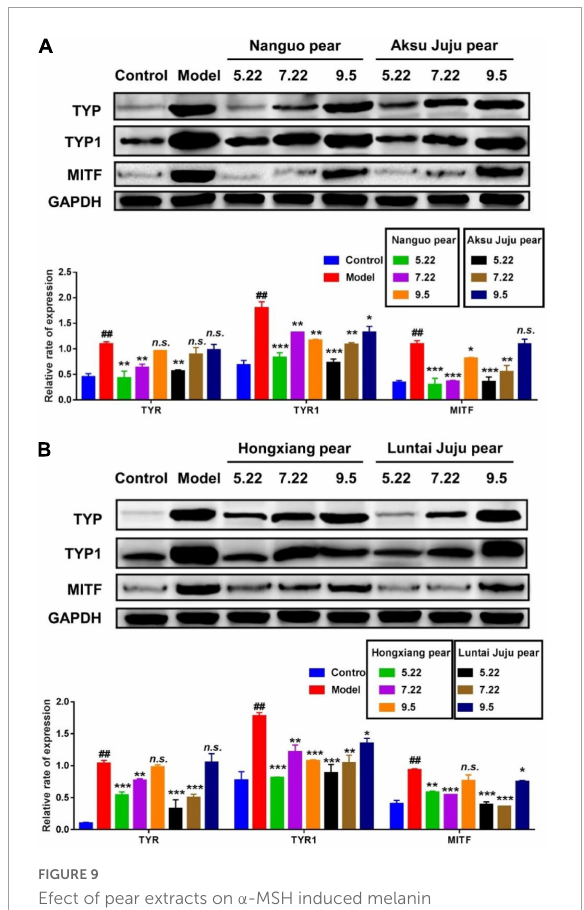
FIGURE9 Efect of pear extracts on α -MSH induced melanin production-related protein levels in B16 cells for 48 h. Western blot analysis of TYR, TYR1, and MITF levels after Nanguo pear and Aksu Juju pear (A) , Hongxiang pear and Luntai Juju pear extracts (B) treatment. GAPDH protein was used as an internal control. All data represent means ± SD of three independent experiments. ## p < 0.01, compared with control group, *** p < 0.001, ** p < 0.01 and * p < 0.05 related to model